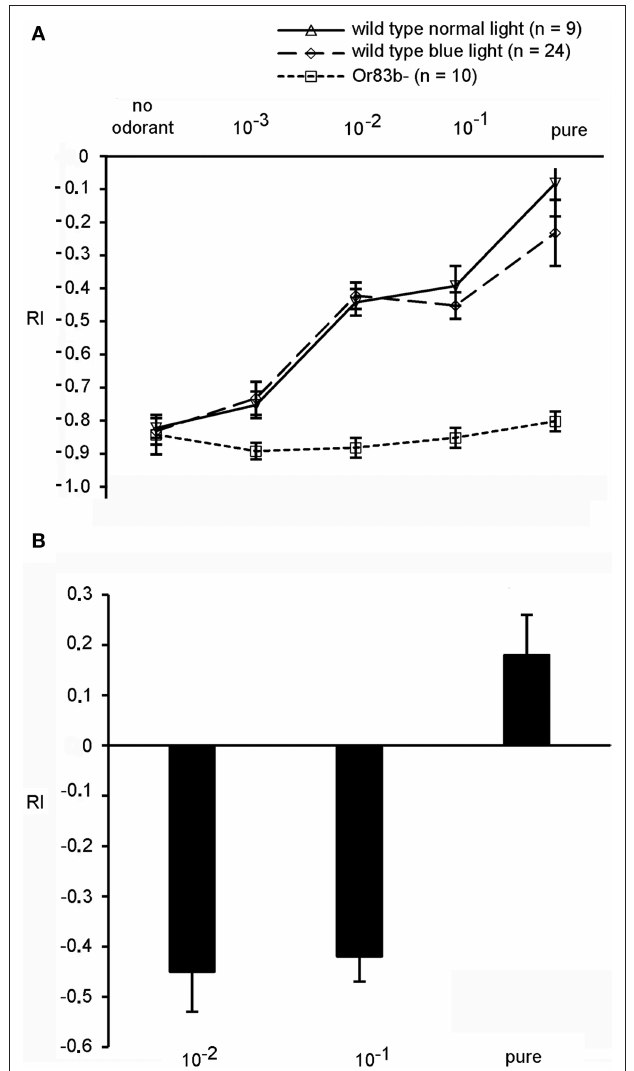
Figure 3 | (A) Behavior of wild type larvae exposed to either white or blue light and benzaldehyde in the illuminated quadrants (n = 15). The anosmic mutant Or83b − shows only a negative phototactic response, while wild type larvae are more attracted by increasing concentrations of benzaldehyde, as indicated by the decreasing RI values. (B) Wild type larvae exposed to different concentrations of octyl acetate. With undiluted concentration of octyl acetate applied in the dark quadrants larvae escaped into illuminated sections of the Petri dish. Bars represent means ± SEM ( n = 15).